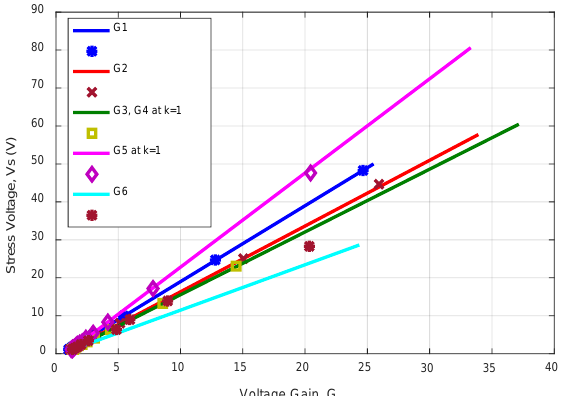
Figure 20. The relation between voltage gains and voltage stress, solid lines: theoretical results, marks: simulation results.